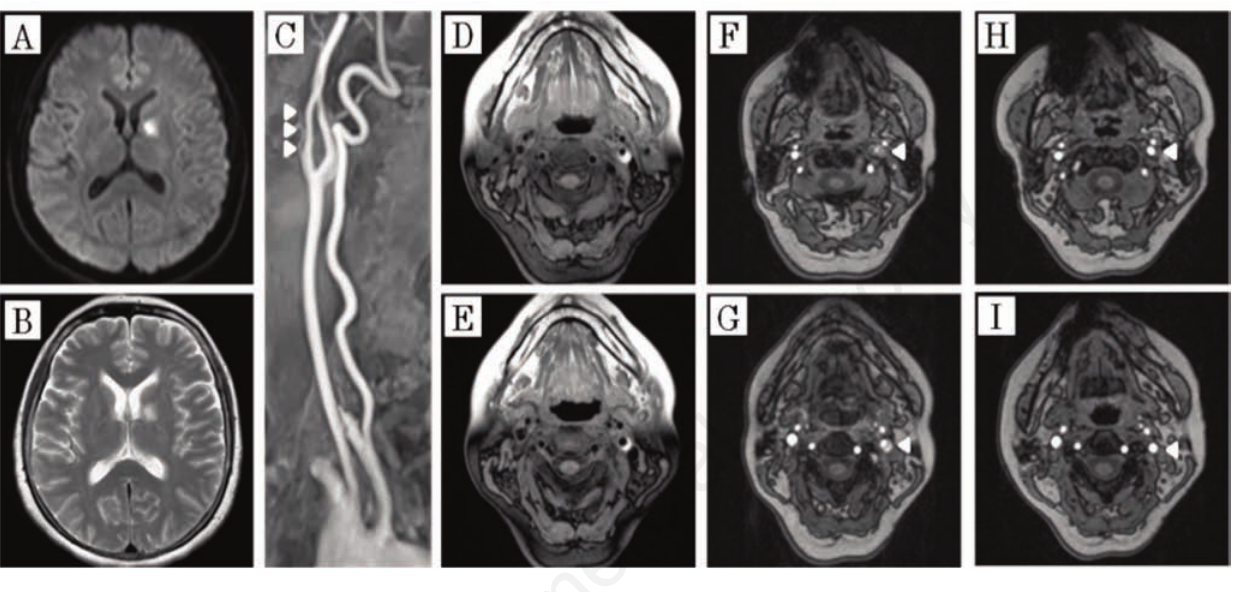
Figure 1. Diffusion-weighted (A) and T2-weighted (B) magnetic resonance imaging (MRI) of the brain shows a hyperintense lesion in the genu of the left internal capsule and globus pallidus. Magnetic resonance angiography (MRA) of the neck reveals narrowing of the left distal carotid sinus (C, arrowheads ) surrounded by hyperintensities seen on both T2-weighted (D,E) and T1-weighted (F,G, arrow- head ) sequences, which represent a periluminal hematoma secondary to carotid artery dissection. On 110th day after admission, MRI of the neck showed less severe stenosis of her left carotid artery (H,I,